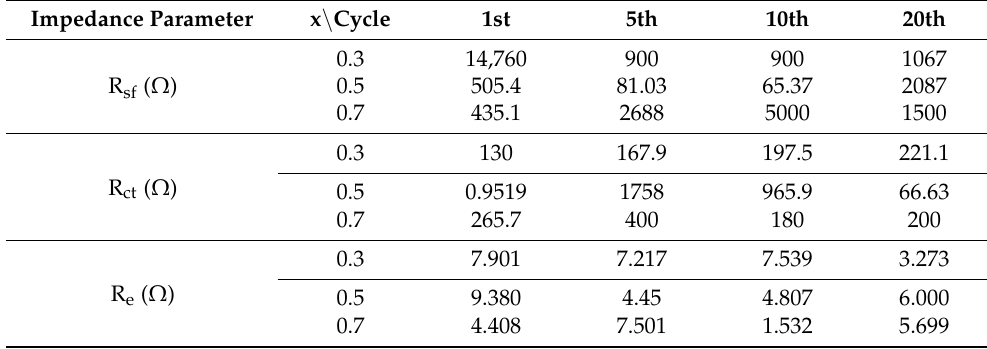
Table 2. Impedance parameters obtained after fitting the EIS experimental data based on the EEC model shown in Figure